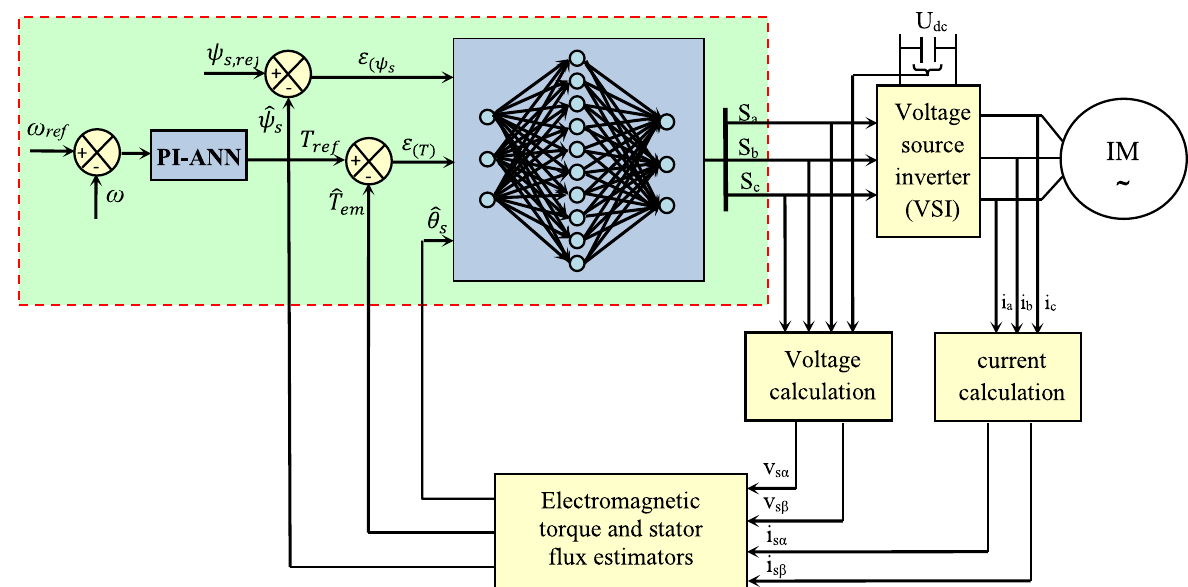
Fig. 8 Synoptic schema of DTC-ANN control of the induction